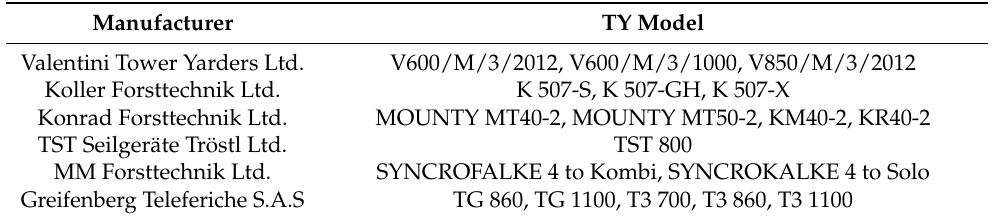
Table 2. Diesel-hydraulic TY models in the four to five ton range and manufacturers considered in defining the performance requirements given in Table 1.